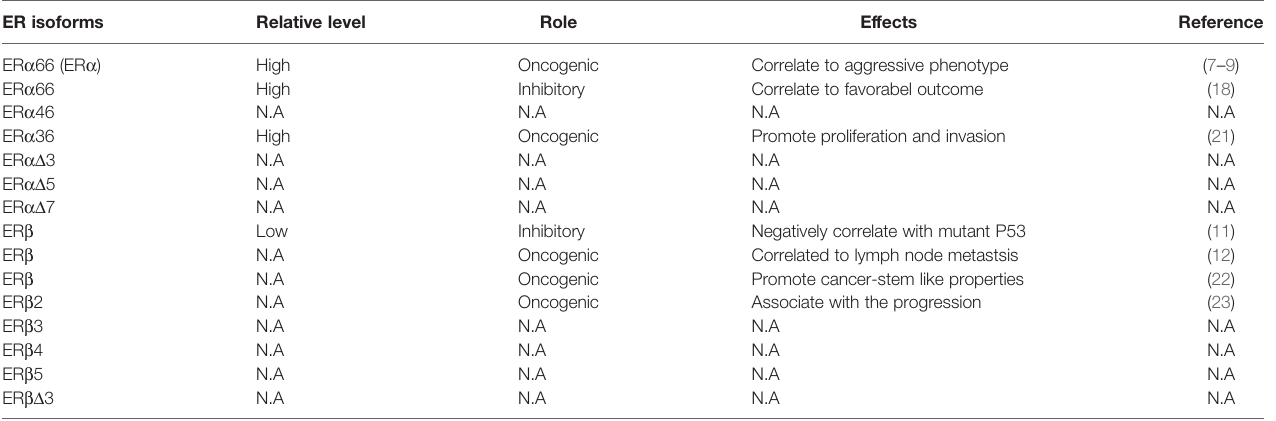
TABLE 1 | The expression of ERs isoforms and their roles in thyroid cancer. ER